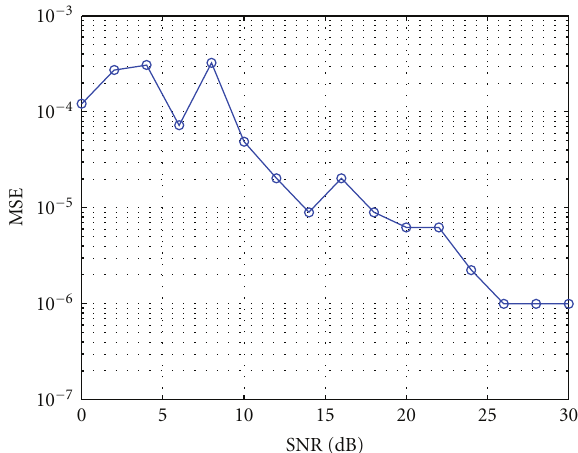
Figure 17: Sparse pilot-based measured MSE of CFO versus SNR performance curve. CFO = 45KHz.